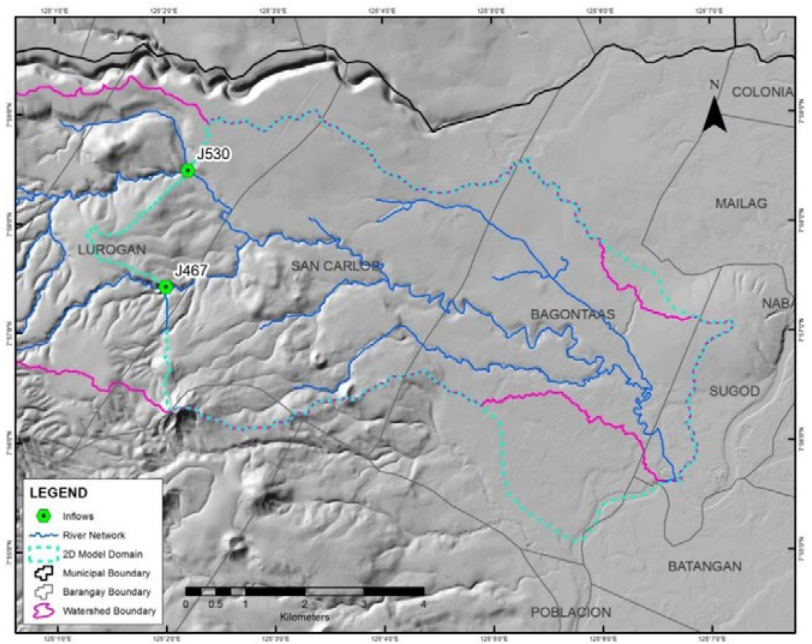
Fig. 3: 2d model domain (floodplain) of Malingon River for HEC-RAS